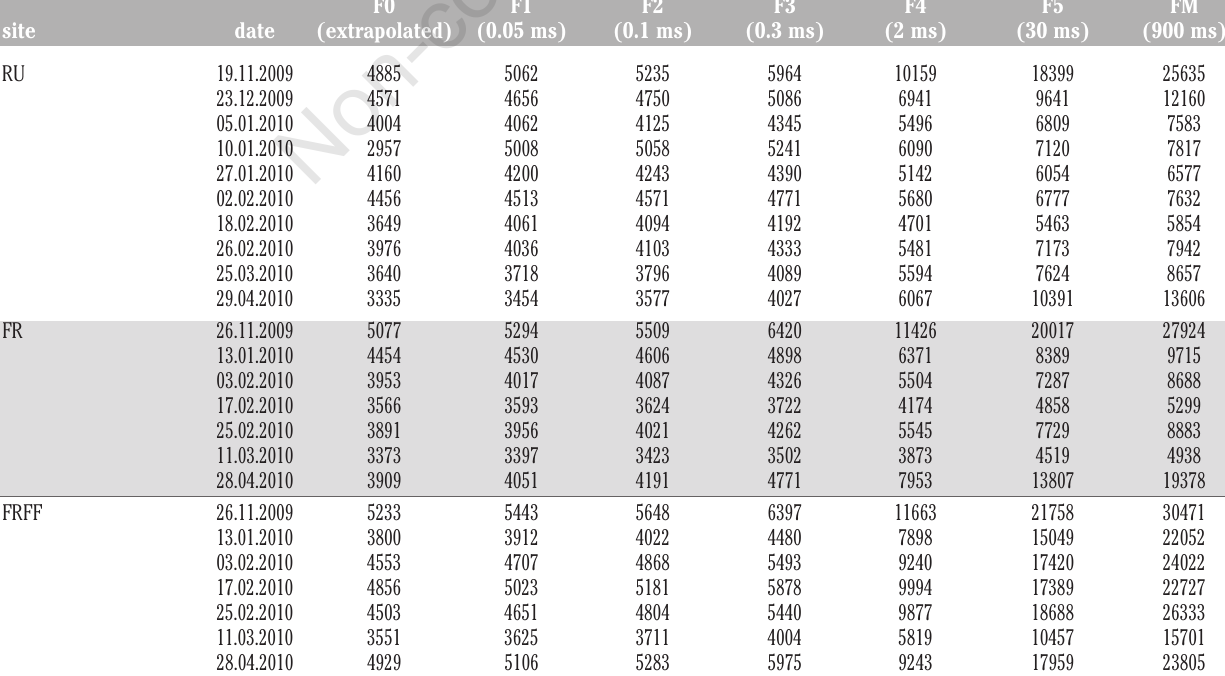
Table 1. Mean values of raw fluorescence intensities of the Pocket-PEA measurements at T0-T5 and for the maximum fluorescence (FM) for all data points in Figures 3-4 obtained at the Rüsselsheim site (RU), at the Frankfurt site outdoors (FR) and at the Frankfurt site under frost-free conditions (FRFF); average SDs were 17-28% of the